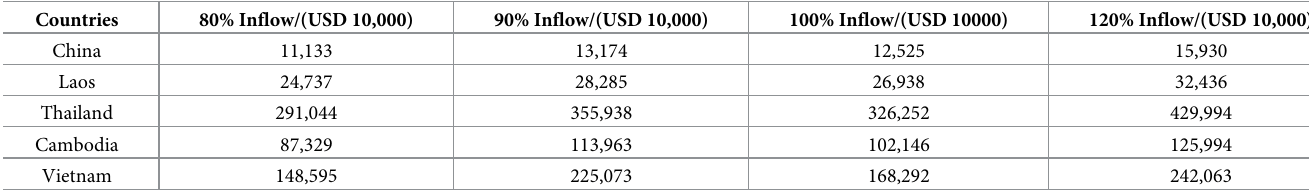
Table 12. Benefits of independent development of water resources in the five countries.